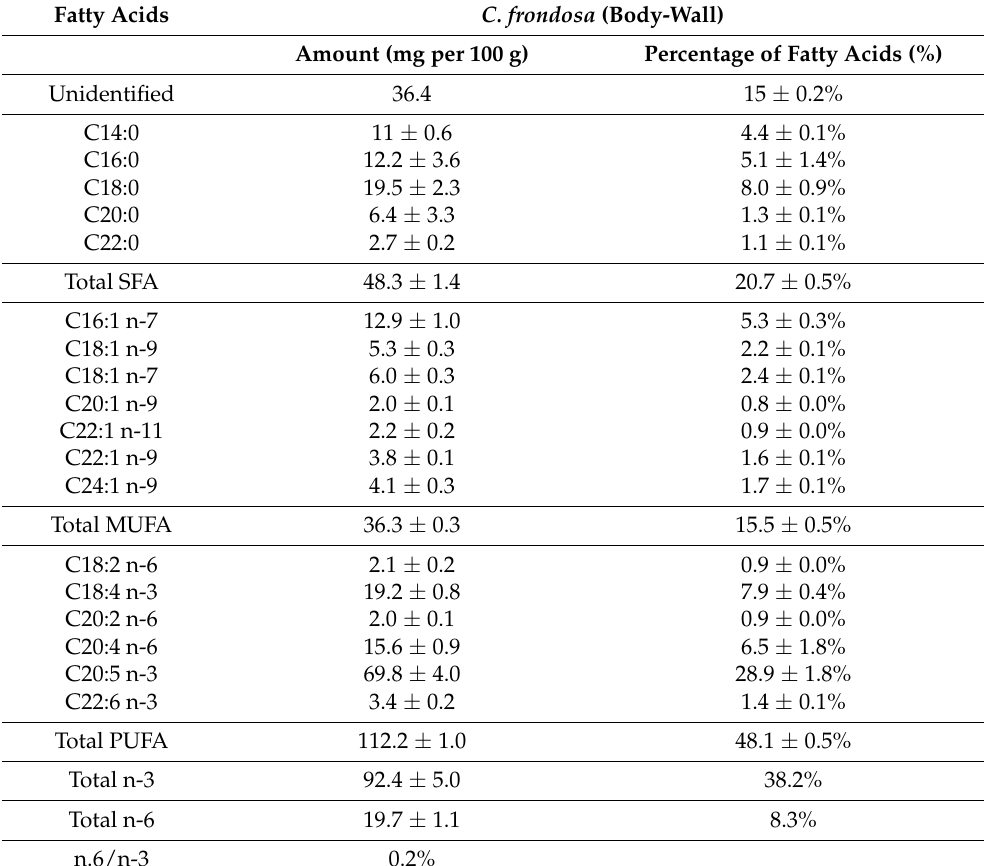
Table 2. Fatty acid composition (percentage of total fatty acids) and amount fatty acid (mg per 100 g) of wet weight orange-footed sea cucumber ( Cucumaria frondosa ) body-wall (average ± SD, n = 4).